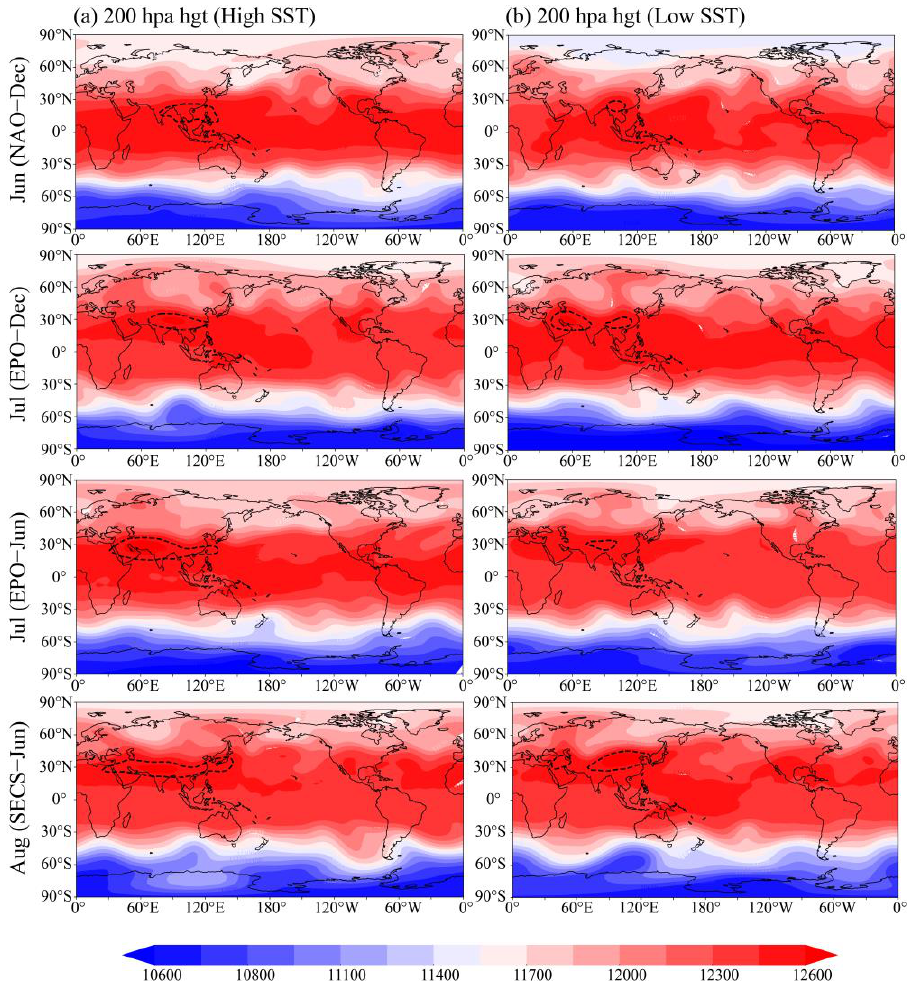
Figure 8. The 200-hpa geopotential height of the summer MLYR in SST anormal years. The black dotted lines define the 12,600 gpm; ( a , b ) mark the geopotential height (unit: gpm) anomalies with high SSTs and low SSTs, respectively.